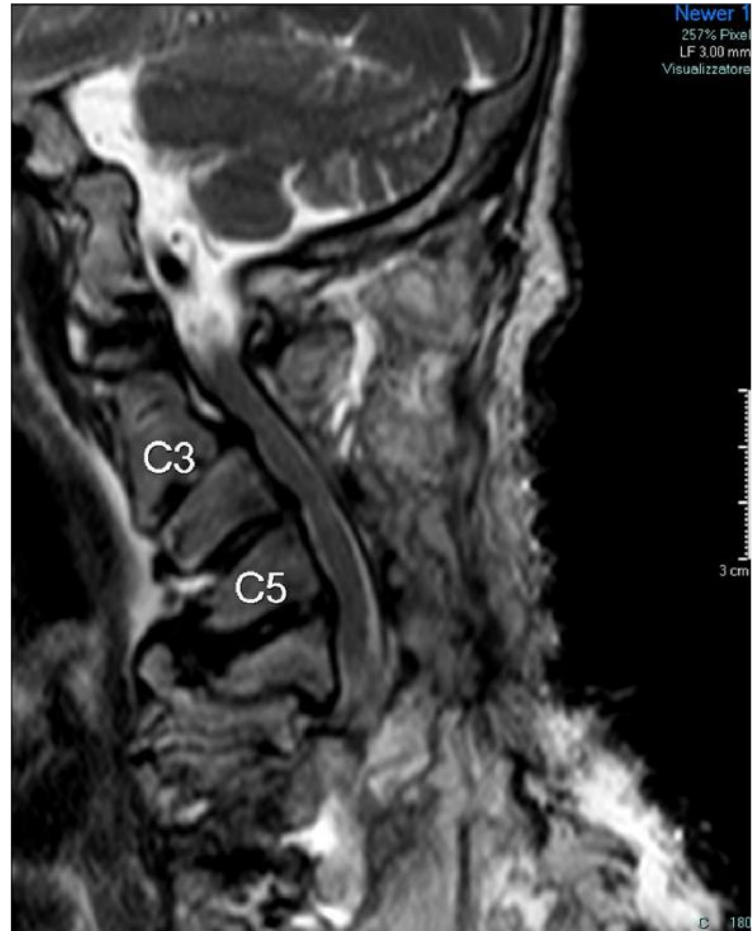
Figure 8. MRI examination at 20 months after surgery. The third (C3) and fifth (C5) cervical vertebrae are indicated by labels.